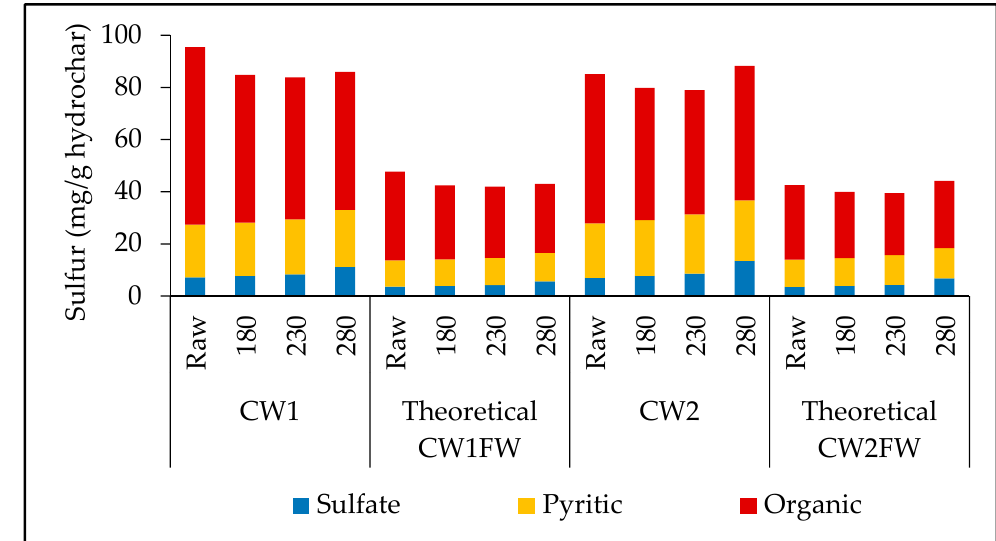
Figure 1. Change of different forms of sulfur in CW-derived hydrochar under various HTC temperatures and theoretically calculated values in CW and FW blended hydrochar at corresponding Co-HTC temperatures. “Raw” indicates the feedstock without any treatment. Note: there was no sulfur content observed in the FW feedstock and its hydrochar.